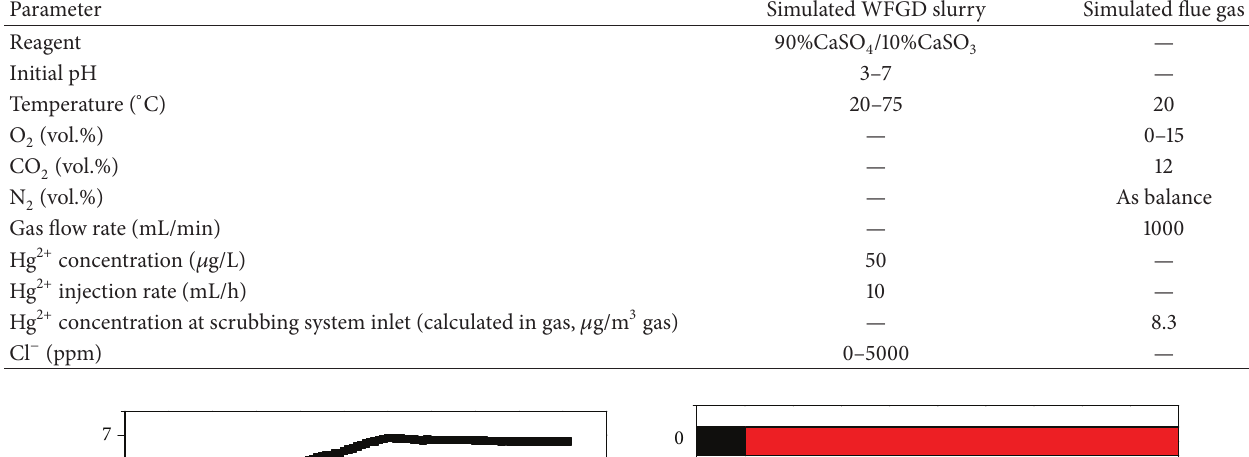
Table 1: Experimental conditions.